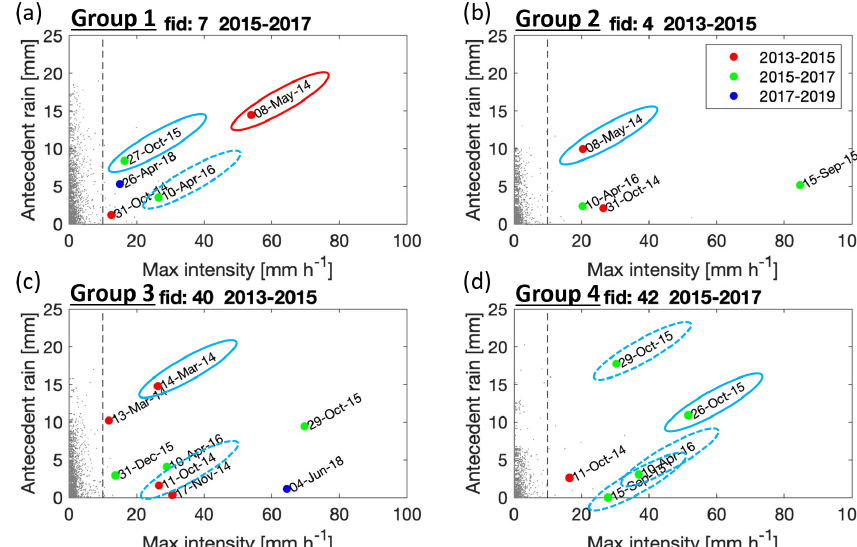
Figure 10. Scatter plots of antecedent rainfall versus maximum 5min rain intensity observed over four DFs representative of the four groups (a–d) for all the storms observed in the radar archive in the period 2013–2019. Data points exceeding the intensity of 10mmh − 1 for 5min intensity and 5mmh − 1 for 30min intensity are marked by color and classified according to the time interval specified by the DoDs. Potential triggering storms (bolded text in Table 1) are marked with dashed blue ellipses, whereas the most likely triggering storms identified in this study are marked with a continuous blue ellipse. The red ellipse in group 1 marks the storm of 8 May 2014, discussed at the end of this